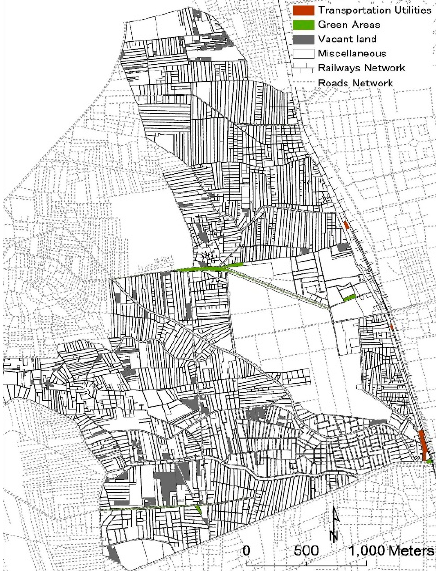
Figure 9. Open spaces in Boulaq.